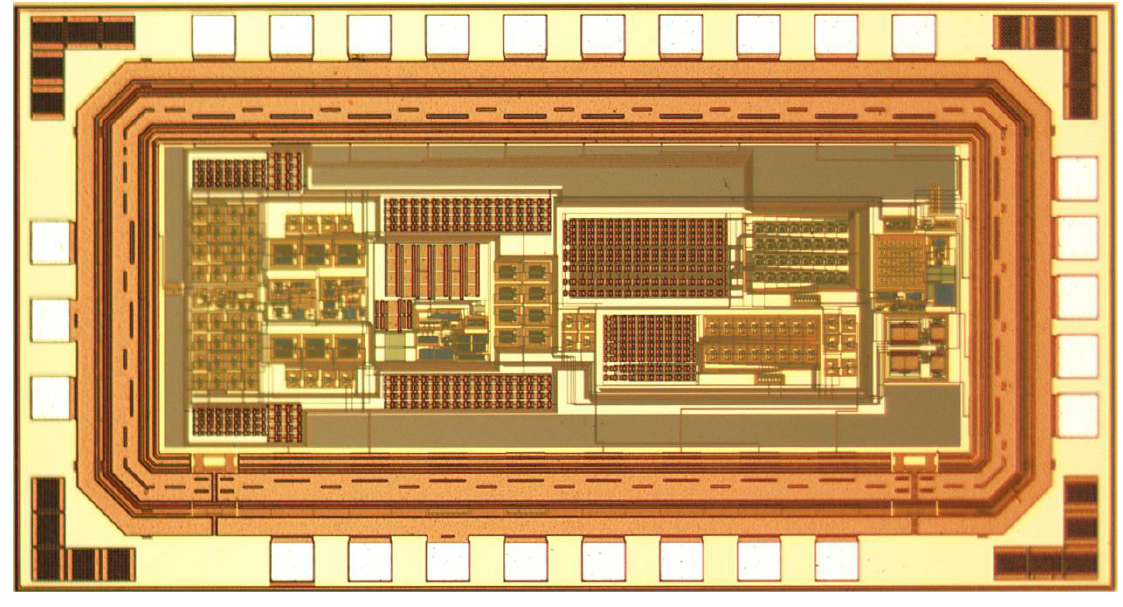
Figure 9. Micrograph of the CDC chip.